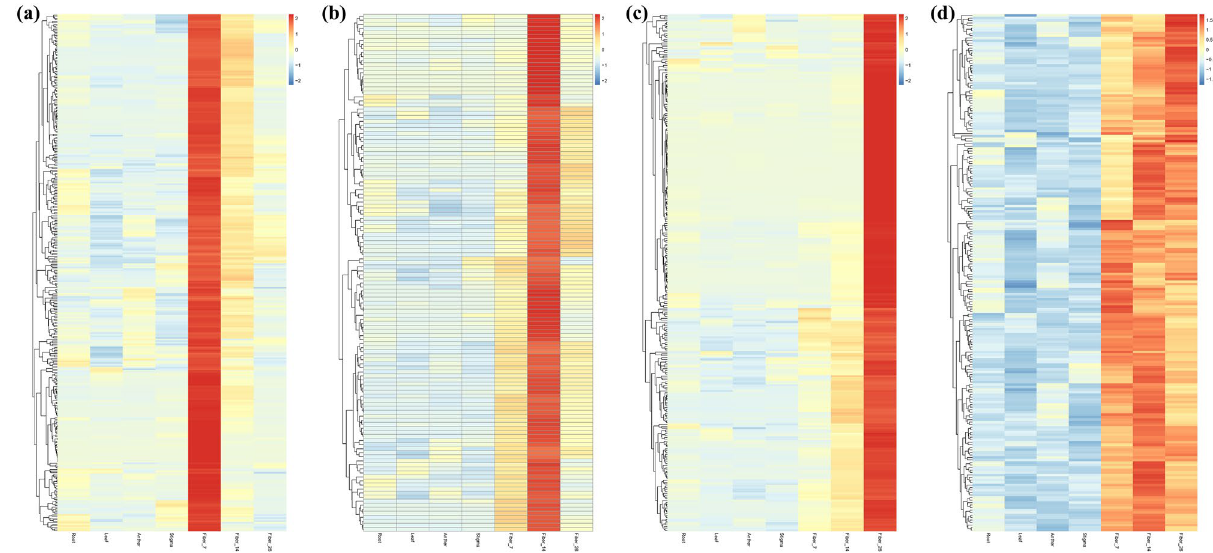
Figure 9. Heatmap of highly abundant genes expressed in different periods of fiber elongation and development (based on a p value < 0.05, the screening parameters between fibers and nonfibers were |Log2(Fold Change)| > 2, and the screening parameters between fibers at different elongation and development stages were 0.5 < |Log2(Fold Change)| < 1.5.). ( a ) Heatmap of highly abundant genes expressed in 7 DPA fibers; ( b ) heatmap of highly abundant genes expressed in 14 DPA fibers; ( c ) heatmap of highly abundant genes expressed in 26 DPA fibers; ( d ) heatmap of highly abundant genes expressed in the whole period of fiber elongation and development.